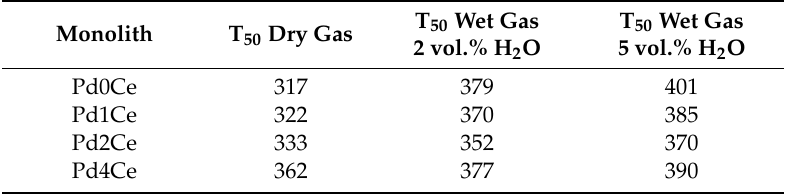
Table 4. Temperature-programmed oxidation T 50 conversion for the catalysts in dry and wet feed gas. [Reaction conditions: GHSV = 36,000 h − 1 , Feed composition: 0.07 vol.% CH 4 , 8.5 vol.% O 2 , 0.06